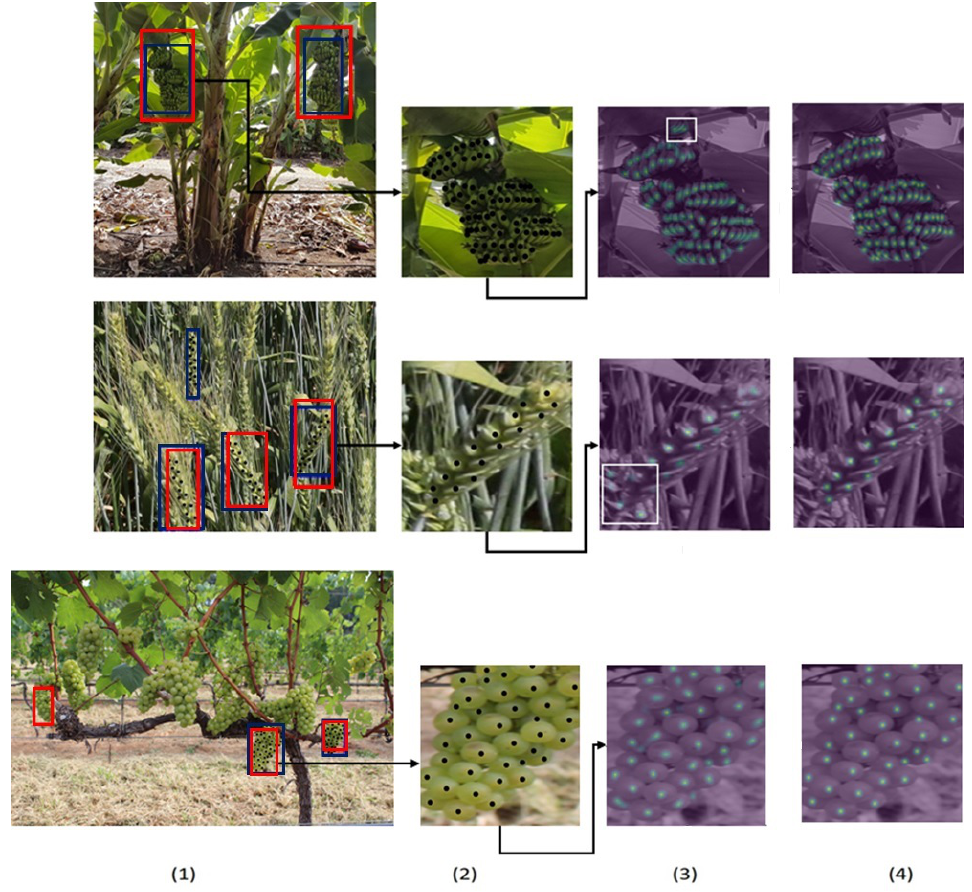
Figure 4. Example of the network’s stages performance with the D+R pipeline. Top Row: Ba- nana, Middle Row: Wheat, Bottom Row: Grapes. ( 1 ). Object detection (blue-ground truth, red- predictions),( 2 ). Getting image crops of the detected objects, ( 3 ). The final predicted heat map of the part’s centers. White rectangle shows the detections of unannotated parts, found by the predicted map, ( 4 ). Ground truth Gaussisan heat map of the object’s